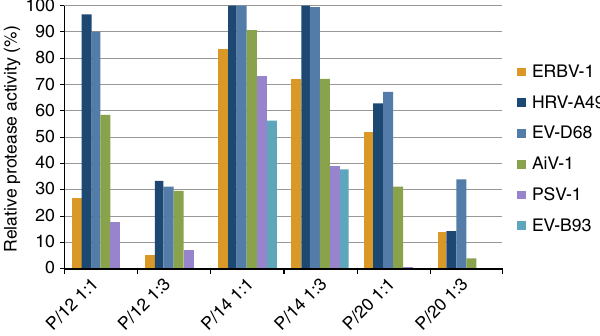
Figure 5 | Inhibition of 6 different 3C proteases by compounds 12, 14 and 20. 3C proteases from equine rhinitis B virus (ERBV-1), human rhinovirus A49 (HRV-A49), human enterovirus D68 (EV-D68), Aichi virus 1 (AiV-1), porcine savelovirus 1 (PSV-1) and human enterovirus B93 (EV-B93) were tested at different protease to inhibitor ratios.